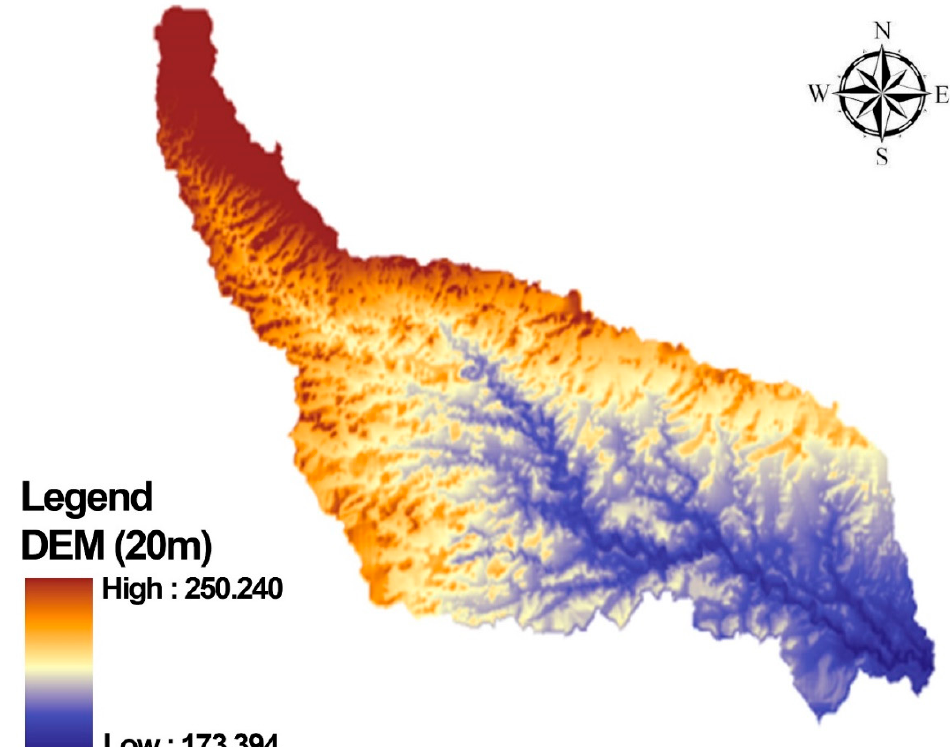
Figure 3. Digital Elevation Model for the Upper Welland River Watershed.